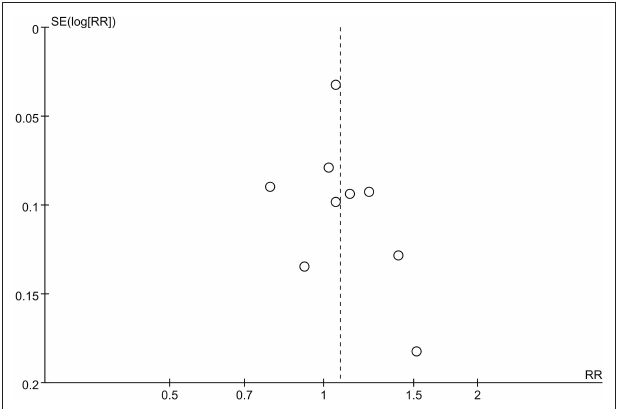
FIGURE 5 | Funnel plot of standard errors against logarithms of odds ratios of studies comparing long-term PVI success rate between Group DC ( + ) and Group DC ( − ).